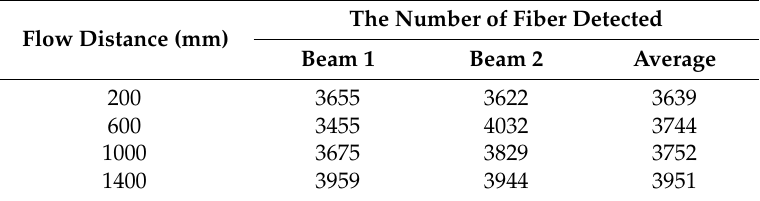
Figure 8. Detected fiber distributions according to the flow distance of UHSFRC. Table 3. The number of fibers detected in the cut section according to the flow distance. The Number of Fiber Detected Flow Distance (mm)